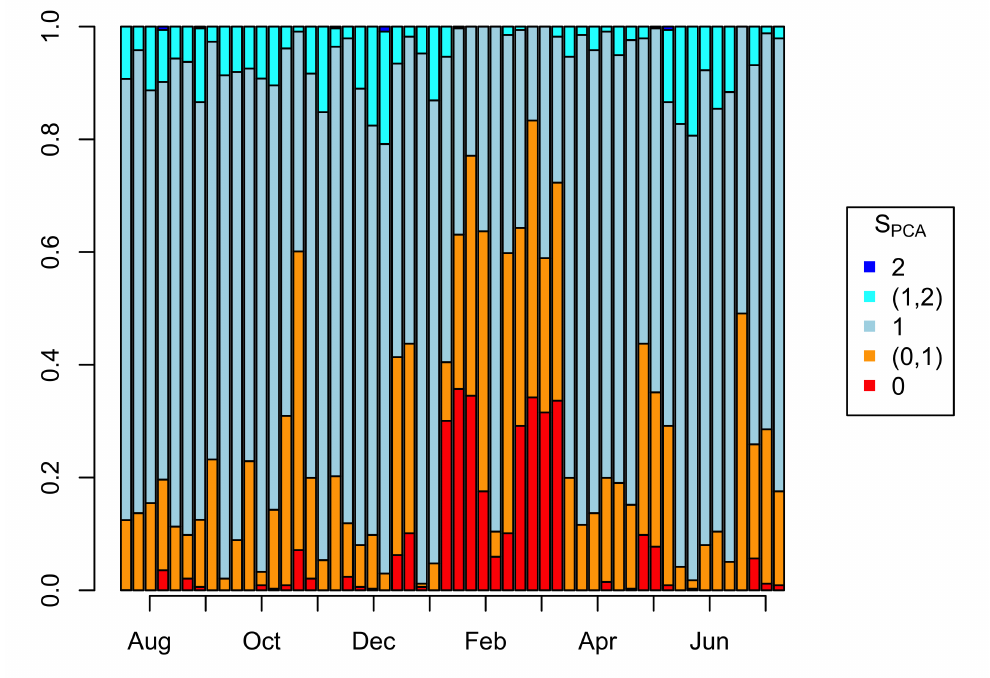
Figure 11. Weekly distribution of the performance index over time for the validation data, with the initial column the total distribution for the training data.